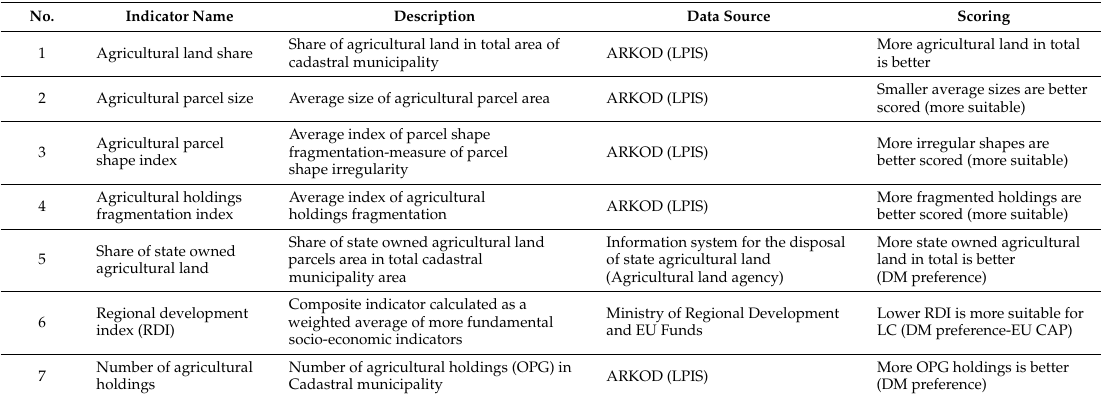
Table 1. Defined data sources and